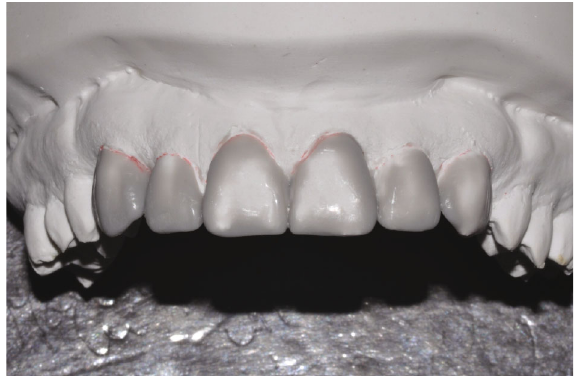
Figure 6: Final wax-up.